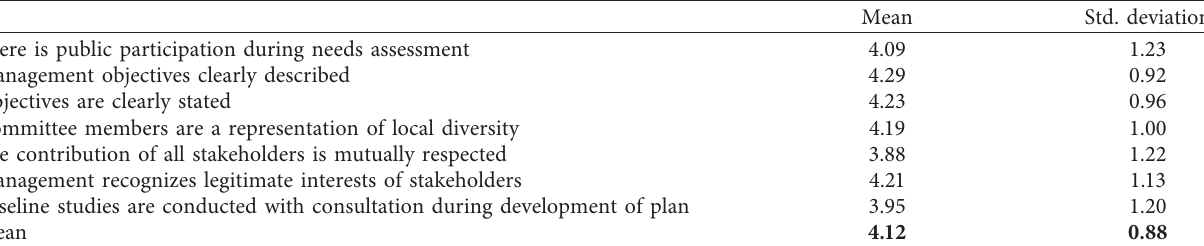
Table 1: Participatory project initiation.